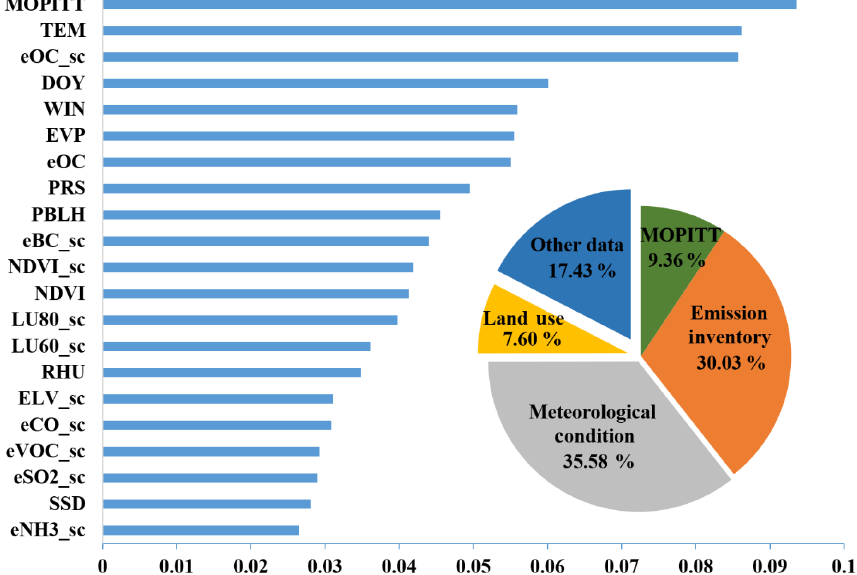
Figure 6. Relative importance of the predictor variables in the RF–STK model. Please refer to Table S1 for the detailed descriptions of these